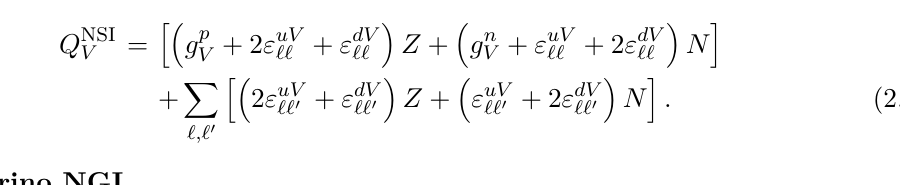
and right chirality projectors, and ε qV are the couplings that describe the relative strength ‘‘ 0 of the NSI in terms of G . These couplings can be either flavor preserving (also called F nonuniversal, ‘ = ‘ 0 ) or flavor changing ( ‘ 6 = ‘ 0 ). Once NSI are introduced, the SM weak charge of eq. (2.2) becomes flavor dependent and is modified 3 as Q SM